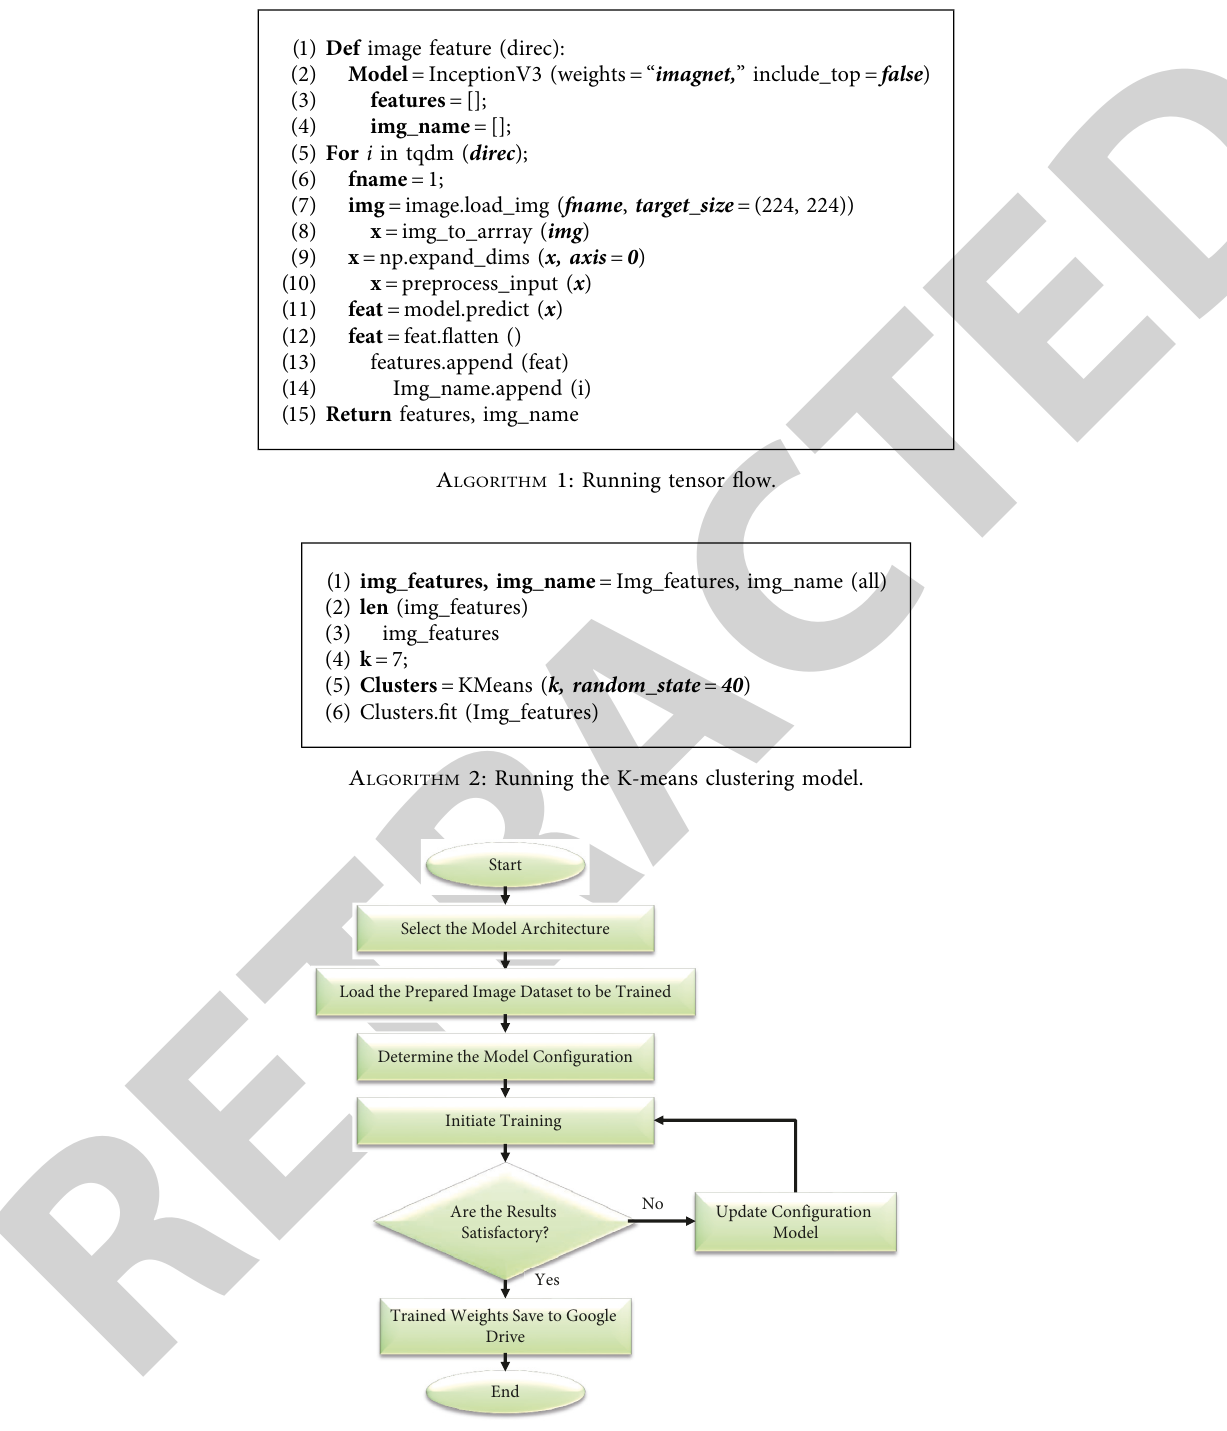
Figure 6: Process for training the